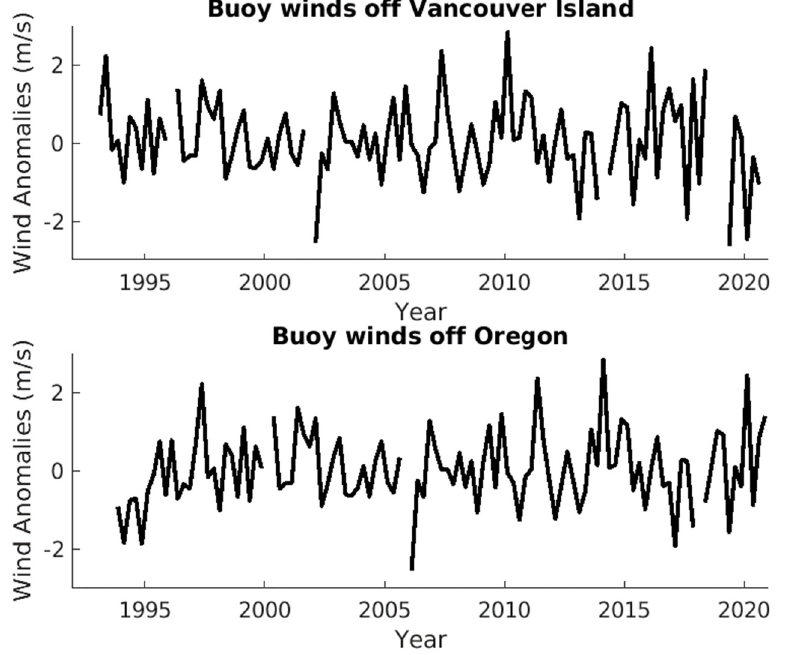
Figure 10. Seasonal longshore wind anomalies at Buoy 46,206 off South Vancouver Island and 46,050 off Oregon.